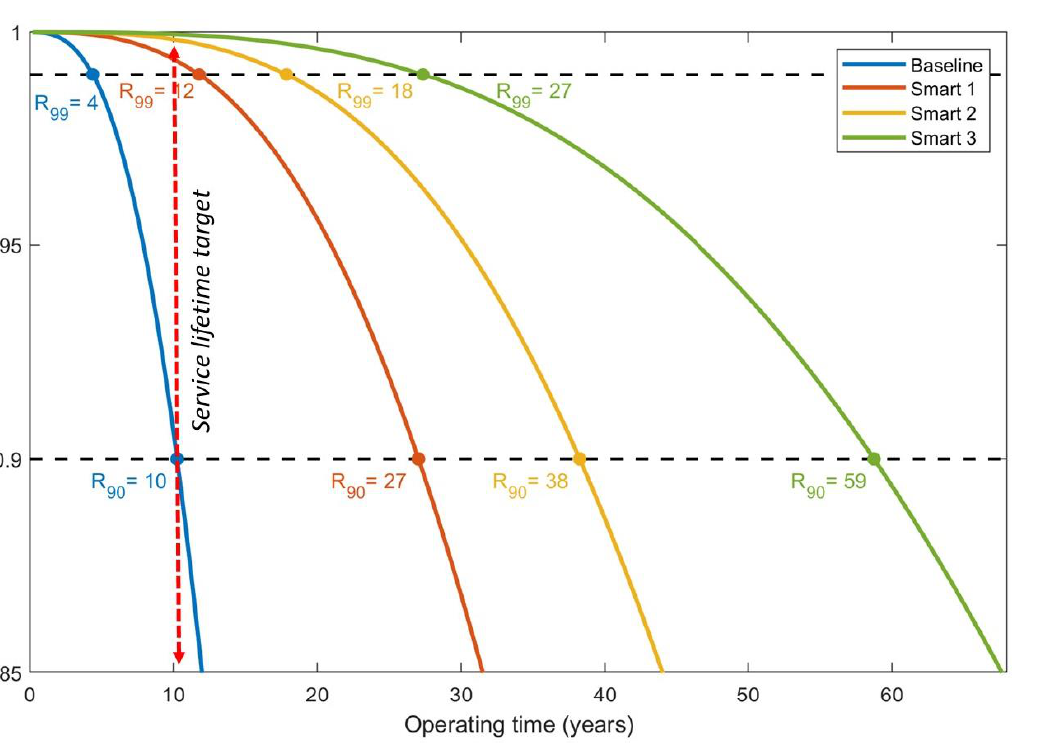
Figure 9. Weibull reliability of the charging system for the considered charging current profiles.